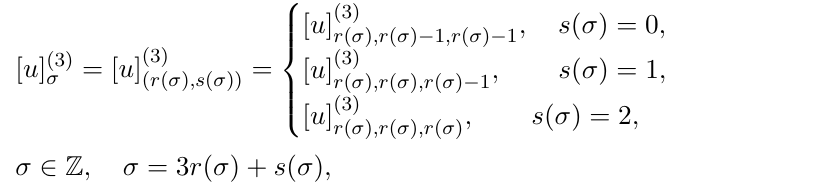
Figure 47. Generalization of Young diagram and correspondence with vectors for one-dimensional crystal of ‘ . The generalized partition is expressed by two numbers ( λ − 1 , τ ) ∈ Z × Z 3 we set τ ∈ Z = { 0 , 1 , 2 } . Using (F.9), it can be written as σ = 3 λ − 3 + τ , r (3 λ − 3 + τ ) = λ − 1 , 3 and s (3 λ − 3 + τ ) = τ